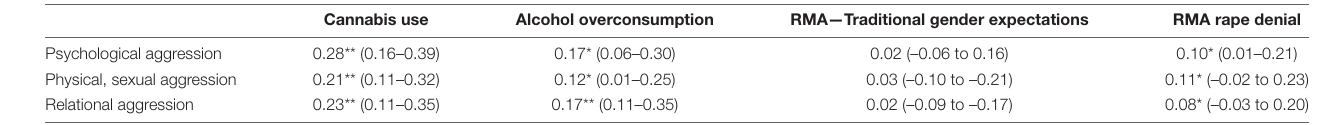
TABLE 8 | Bivariate correlations between Teen Dating Aggression Measure (TeDAM) scales and outcome